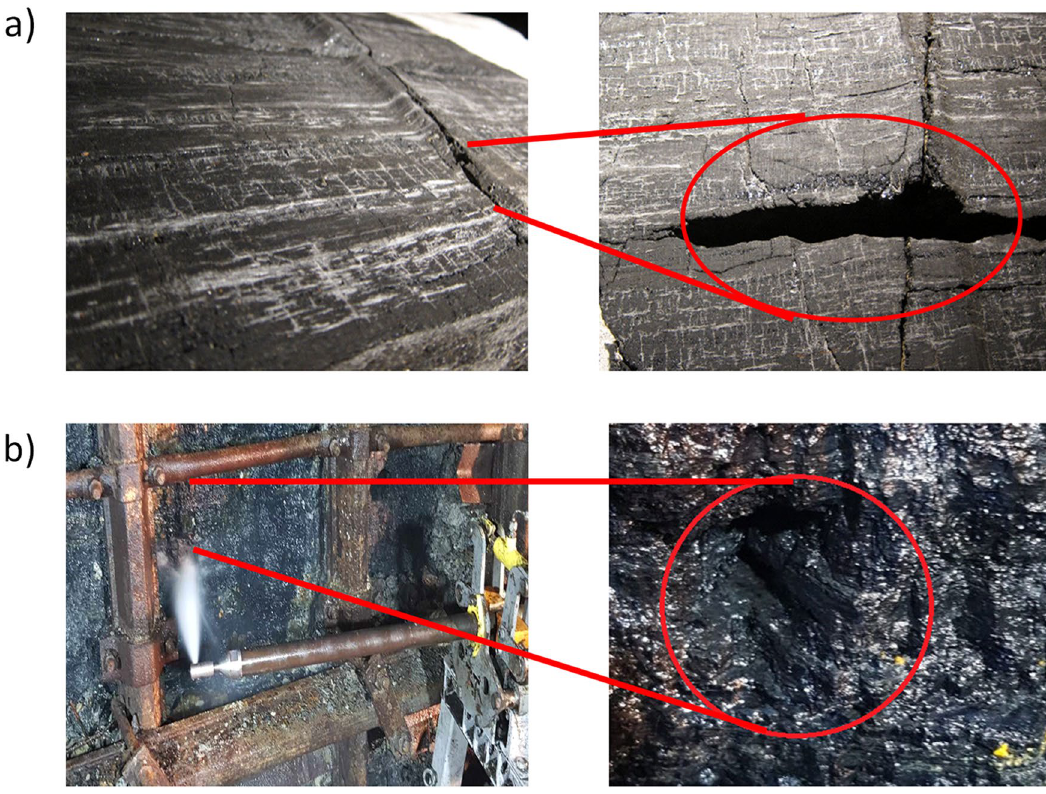
Figure 17. Influence of high pressure water jet on: ( a ) impact in parallel to the coal stratification and ( b ) distance from the coal face. Operating time Pressure (MPa)